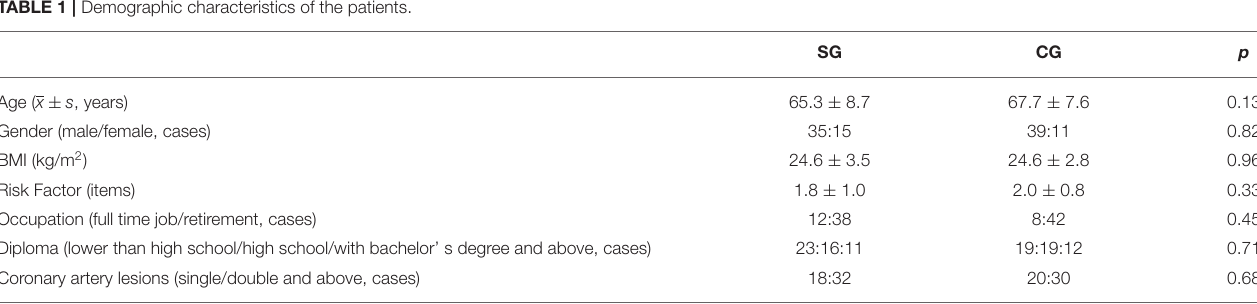
TABLE 1 | Demographic characteristics of the patients.